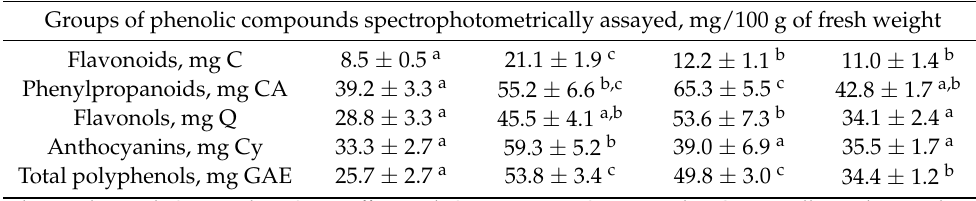
Table 2. Phenolic compound profile and main groups of phenolics in red arils (mean ± SD). Component